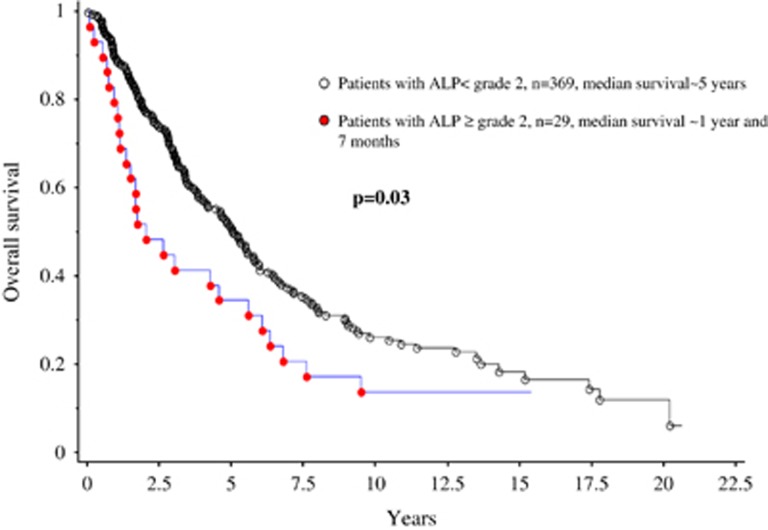
Overall survival in 398 patients with World Health Organization-defined primary myelofibrosis, stratified by the presence or absence of alkaline phosphatase (ALP) ⩾grade 2 elevation per CTCAE.